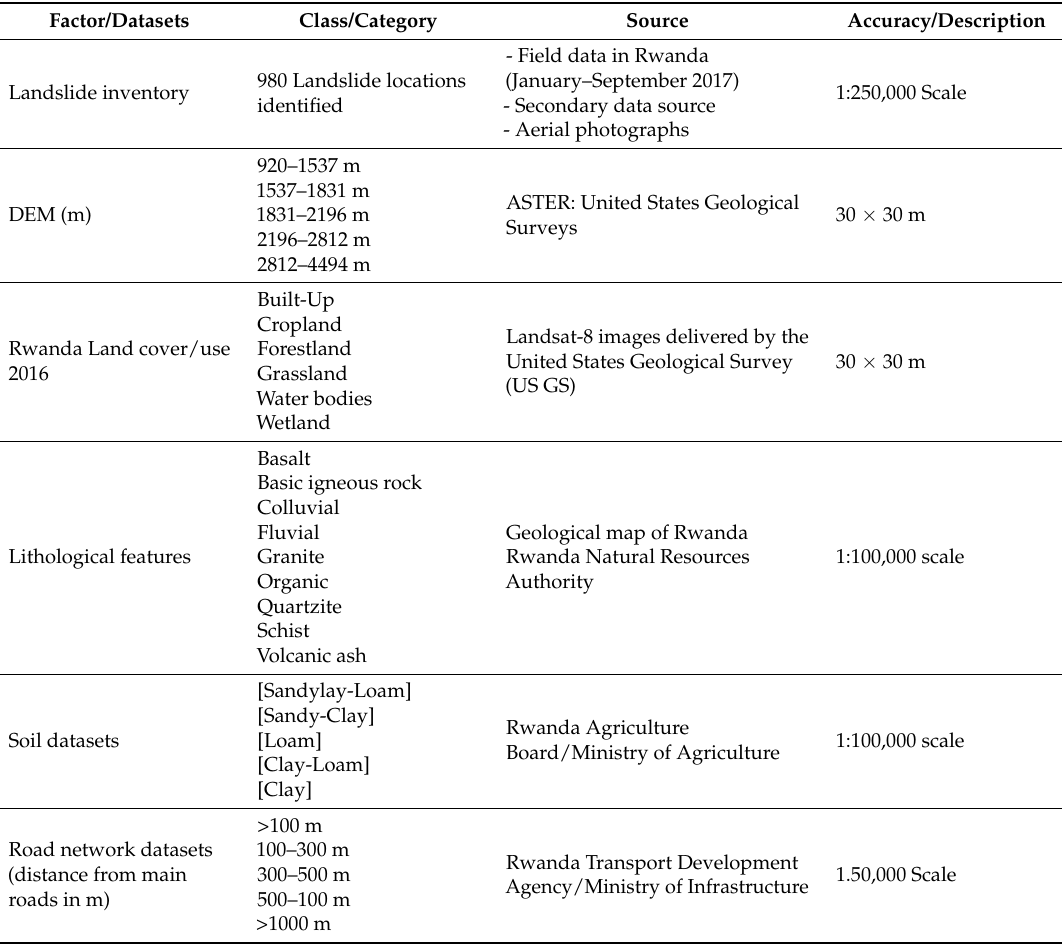
Table 2. Summary of used datasets. The table illustrates major datasets used to model the landslide susceptibility in